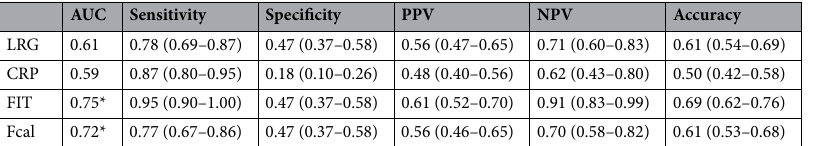
Table 2. Sensitivity, specificity, and predictive values of the serum/fecal biomarkers for MES 0 in UC patients. MES Mayo endoscopic subscore, UC ulcerative colitis, AUC area under curve, PPV positive predictive value, NPV negative predictive value, LRG leucine-rich alpha-2 glycoprotein, FIT fecal immunochemical test, Fcal fecal calprotectin, CRP C-reactive protein. *The AUC value of LRG was significantly lower than those of the two fecal markers (LRG vs. FIT, p = 0.0038, LRG vs. Fcal, p =